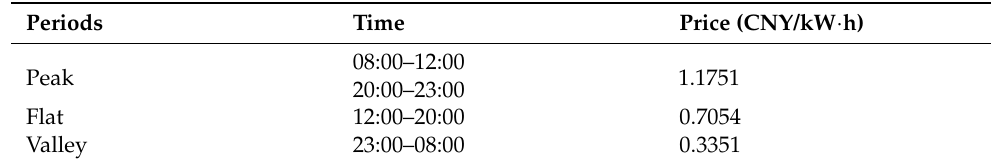
Table 2. Time-of-use prices of grid.